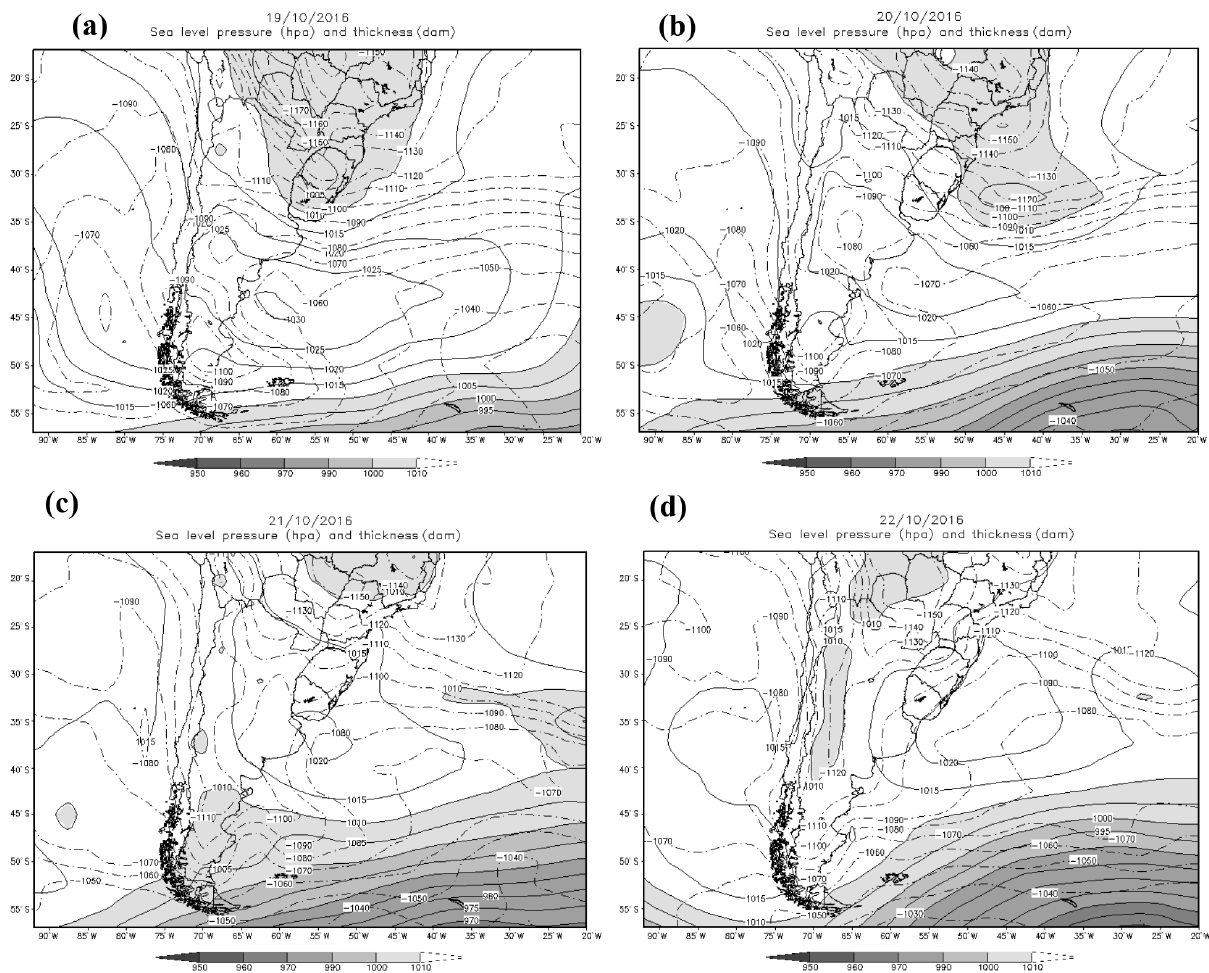
Figure 5. Average daily pressure fields at medium sea level and thickness between 1000 and 500hPa from 19 to 22 October. Shaded areas show pressure levels and dotted lines the